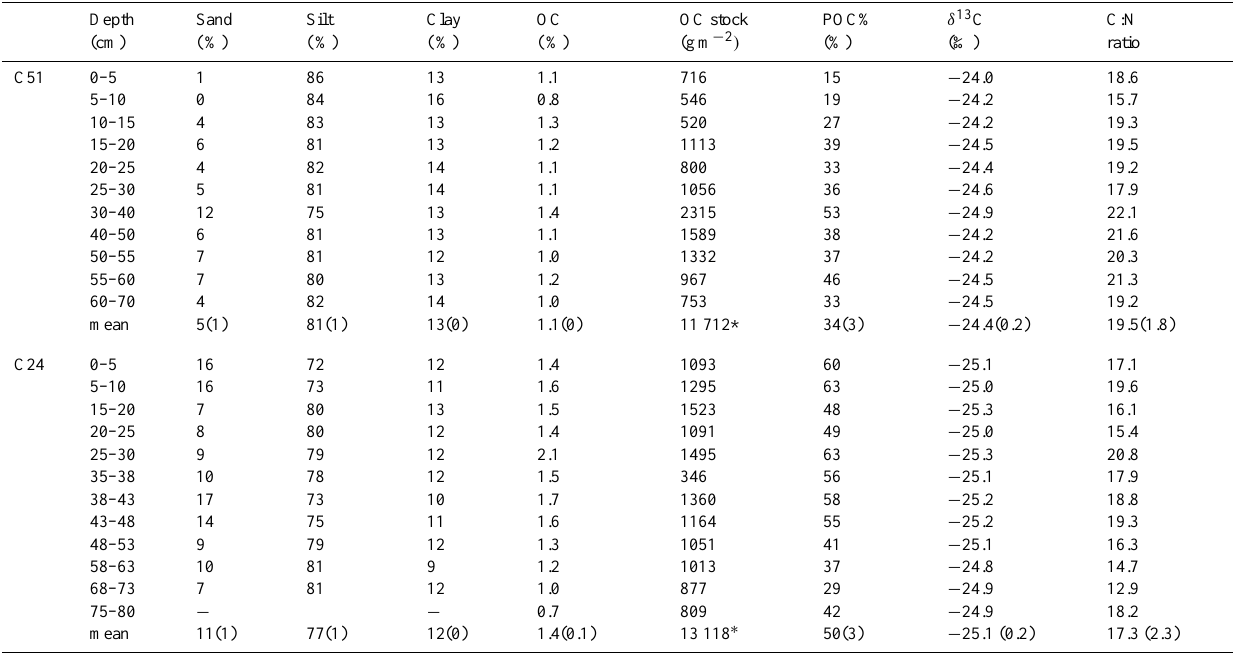
Table 3. Bulk density (BD), clay content, OC concentration, C:N ratio, POC% (percentage of OC > 53µm) and δ 13 C in the A profile of the sediment samples (standard error for the whole profile